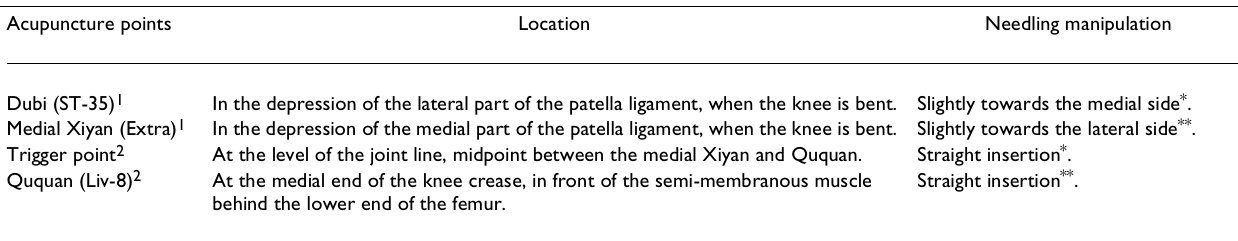
Table 1: The selected acupuncture points used in this study. Acupuncture points